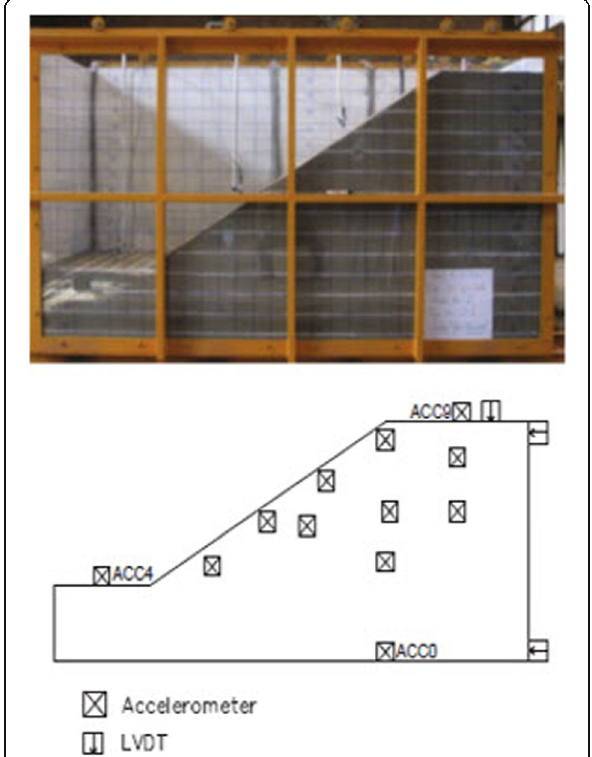
Fig. 19 Instruments installed on physical model (Jafarzadeh et al.